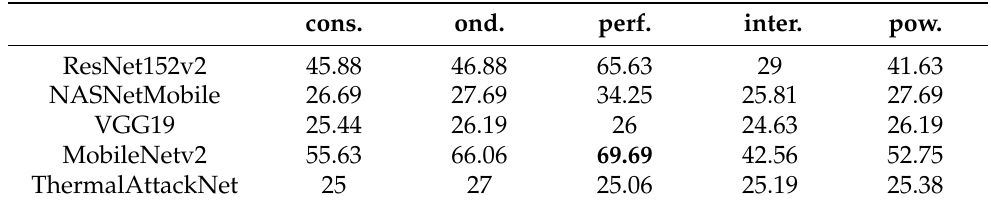
Table 2. Training prediction accuracy (%) achieved by different CNNs on different Linux governors: conservative (cons.), ondemand (ond.), performance (perf.). cons. ond.